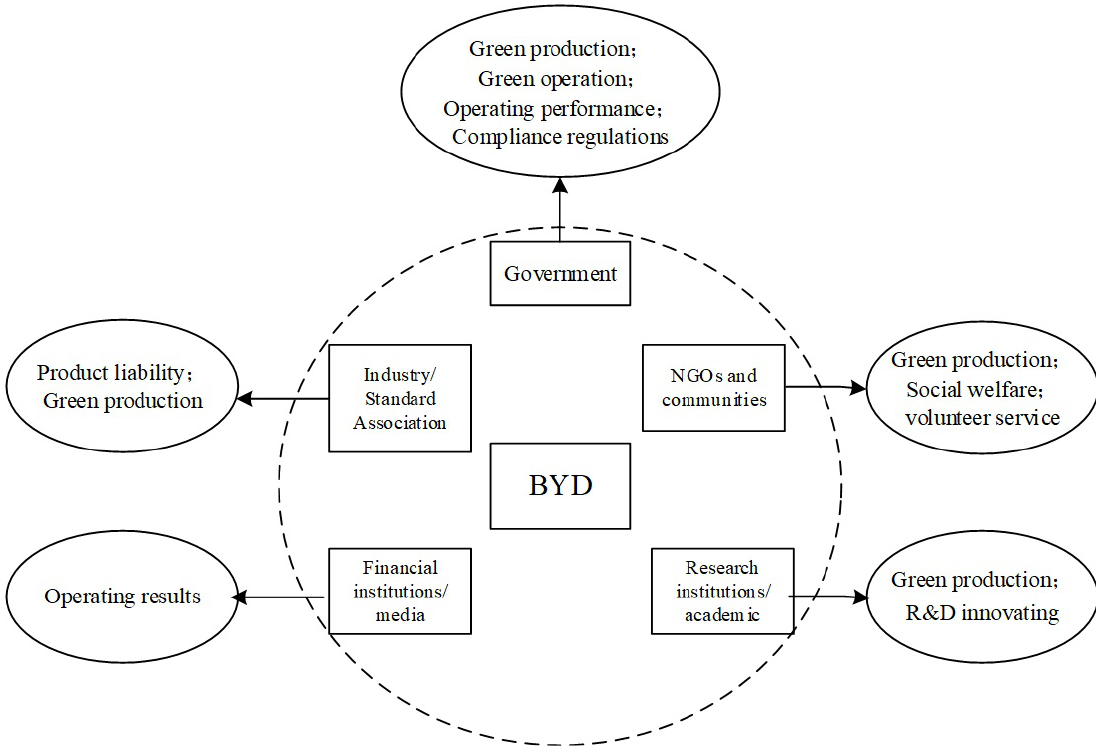
Fig. 2 The main player in BYD green innovation ecosystem and its